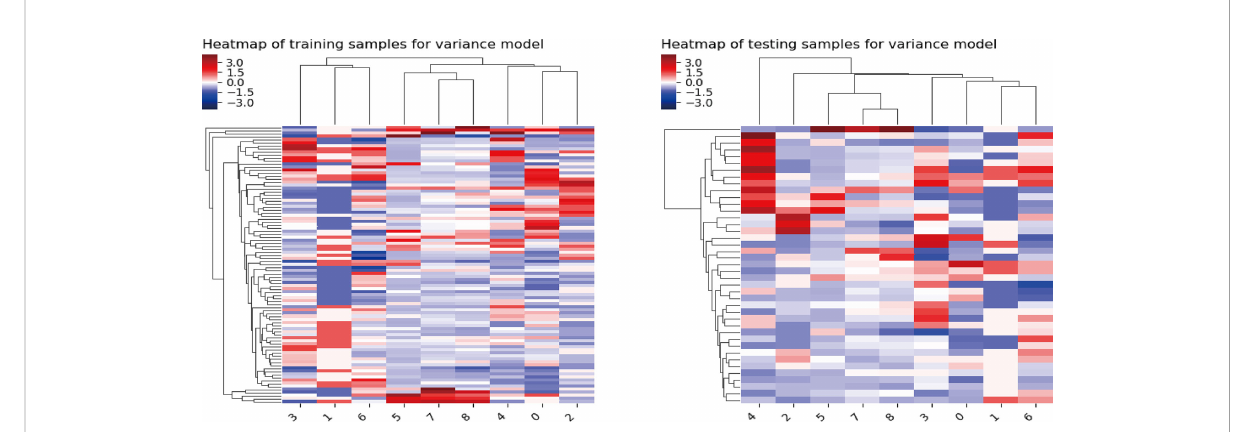
FIGURE 2 Heatmap of the model in the training and validation samples. For both the training samples and the validation samples, the numbers on the x - axis stand for different parameters; right to left represent Kurtosis, Gray-Level Variance, Gray-Level Non-Uniformity, Large Area Emphasis, Coarseness, Long-Run Low Gray-Level Emphasis, Busyness, Joint Entropy, and